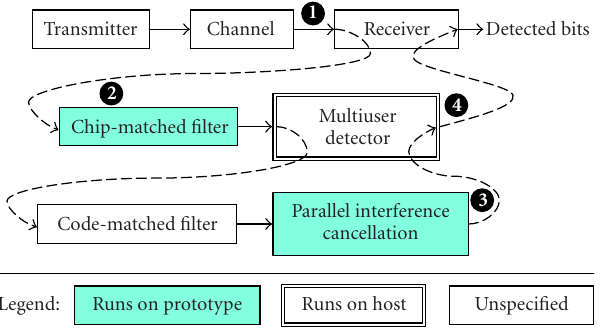
Figure 8: A three-level hierarchical block diagram, showing the child blocks contained by their parents blocks. Dotted lines indicate the connection between a parent and its children. Numbers show a hierarchical traversal of the diagram. Shading and double lines indi- cate labels of “runs on prototype” and “runs on host,” respectively.